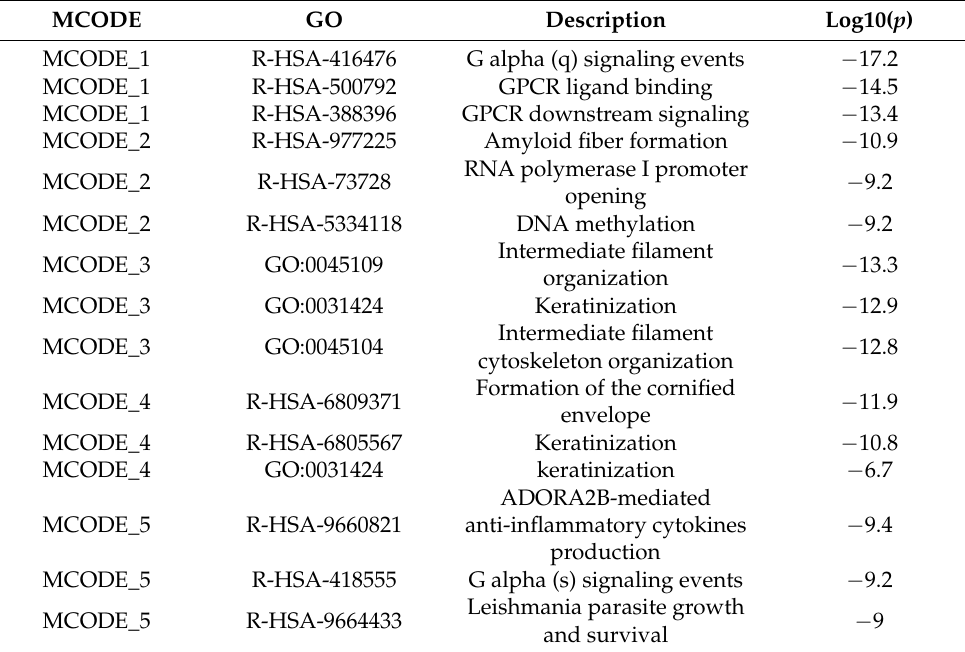
Table 5. GO analysis of the co-expressed genes of CDK1 and